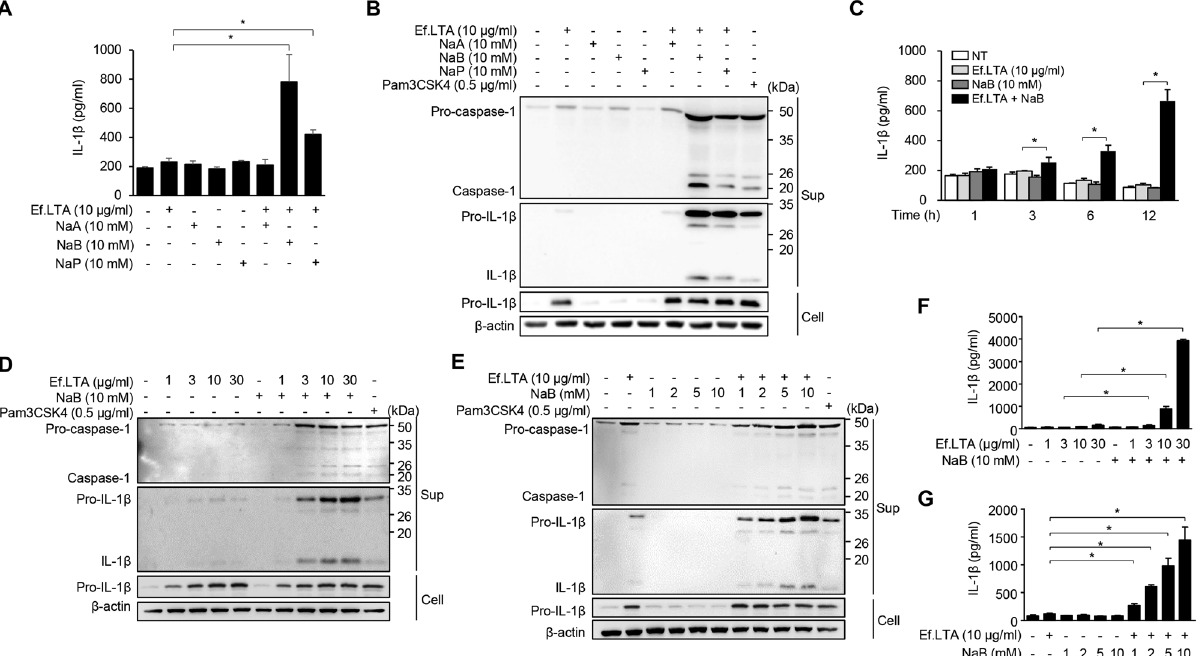
Fig. 1 E. faecalis LTA together with butyrate potently induces IL-1 β secretion and caspase-1 activation in human macrophages. A , B PMA- differentiated THP-1 cells were stimulated with 10 μ g/ml of E. faecalis LTA (Ef.LTA) in the presence or absence of sodium acetate (NaA), sodium butyrate (NaB) or sodium propionate (NaP) for 6 h. A IL-1 β expression in culture supernatants was determined by ELISA. B The pro- or active forms of caspase-1 and IL-1 β in the culture supernatants (Sup) and pro-IL-1 β and β -actin in the cell lysates (Cell) were detected by immunoblotting. C The cells were stimulated with indicated stimuli for various time points and IL-1 β secretion in the culture supernatants was measured by ELISA. D , E The cells were incubated with indicated stimuli for 6 h. Pro- or active forms of caspase-1 and IL-1 β in the culture supernatants (Sup) and pro-IL-1 β and β -actin in the cell lysates (Cell) were detected by immunoblotting. F , G The cells were incubated with indicated stimuli for 6 h. IL-1 β expression in the culture supernatants was measured by ELISA. Pam3CSK4 was used as a positive control. All results are expressed as mean ± SD of triplicate samples. * p <